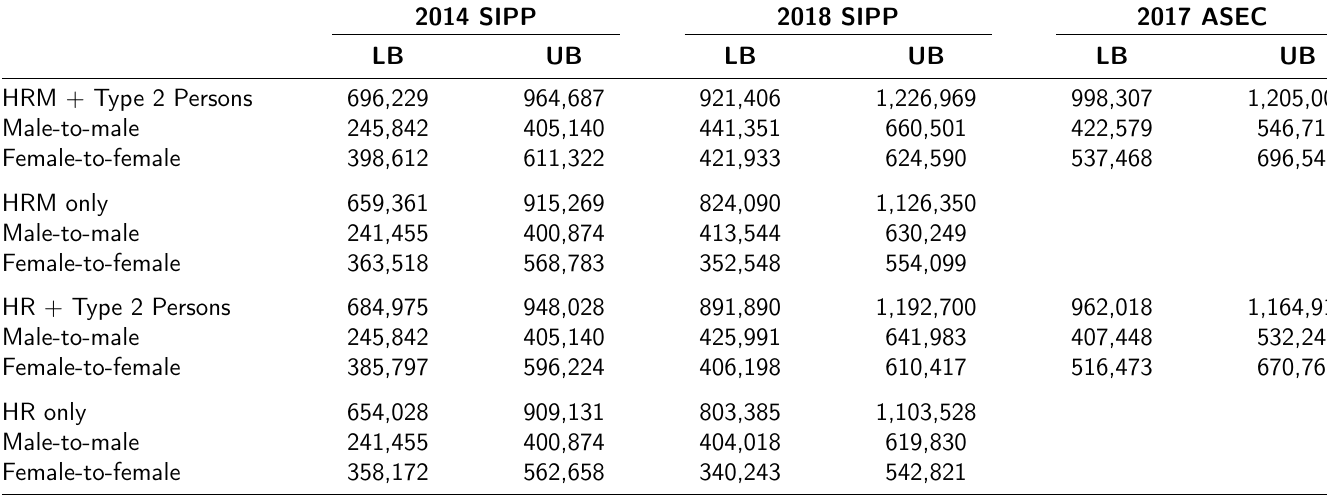
Table A.3: Estimated lower and upper bounds at 95% confidence level for counts in Table 3